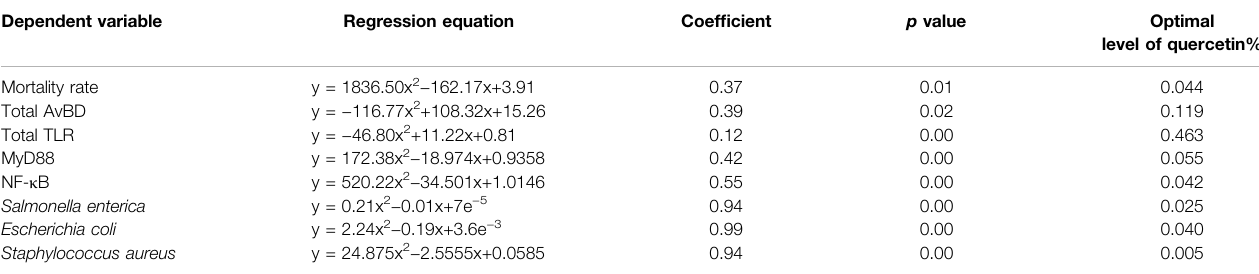
TABLE 11 | Optimal quercetin level in AA broilers on the fi tting curve. Dependent